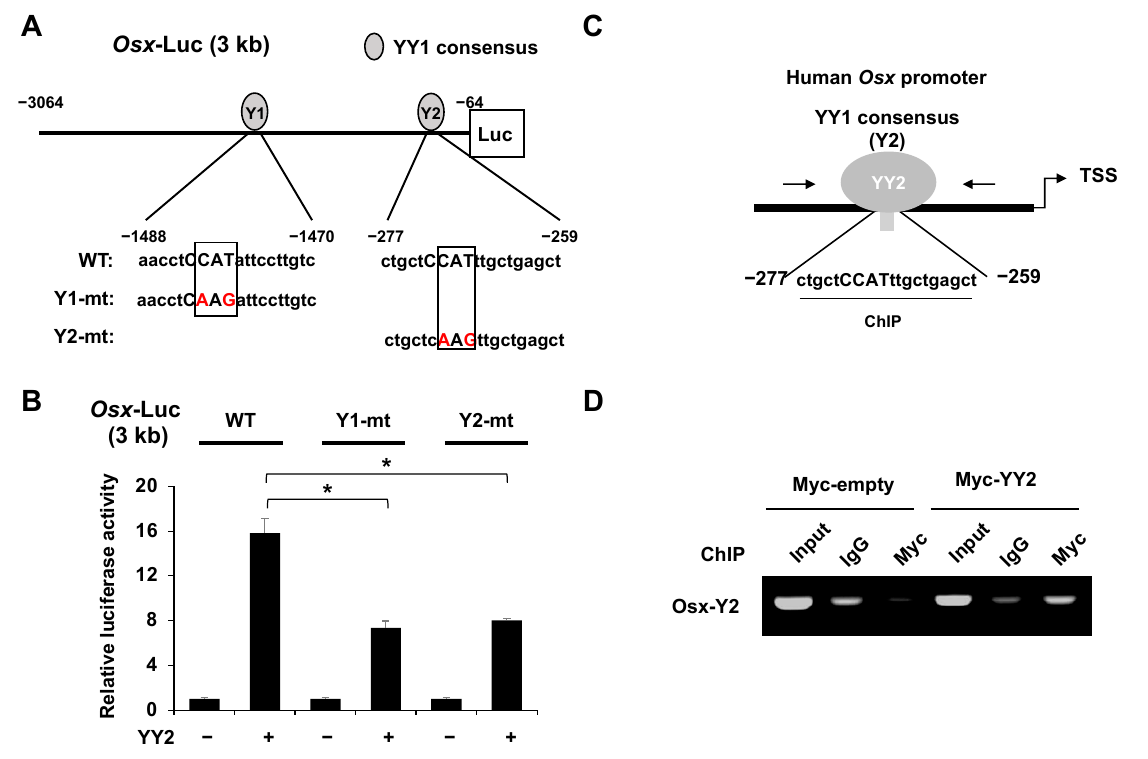
Figure 6. YY2 regulates the Osx promoter by binding to the YY1 consensus motif. ( A ) Schematic diagram of pGL3- Osx promoter mutant forms at YY1 binding site. ( B ) The effect of YY2 on the indicated Osx promoter activity. HEK 293cells were transfected with Osx-Luc (WT, Y1-mt, and Y2-mt) (0.3 µ g) and β -gal (0.05 µ g) and YY2. After 48 h, luciferase activities were measured. YY2- activated Osx promoter activity was significantly attenuated by mutations (Y1-mt and Y2-mt). Data are expressed as mean ± SEM of at least three experiments. * p < 0.05. ( C ) Schematic diagram of ChIP for Y2 site of Osx promoter and YY2. ( D ) ChIP assay was performed on HEK 293 cells using IgG and Myc antibodies. The immunoprecipitated DNA was used as a PCR template to detect the Y2 site of Osx promoter region.